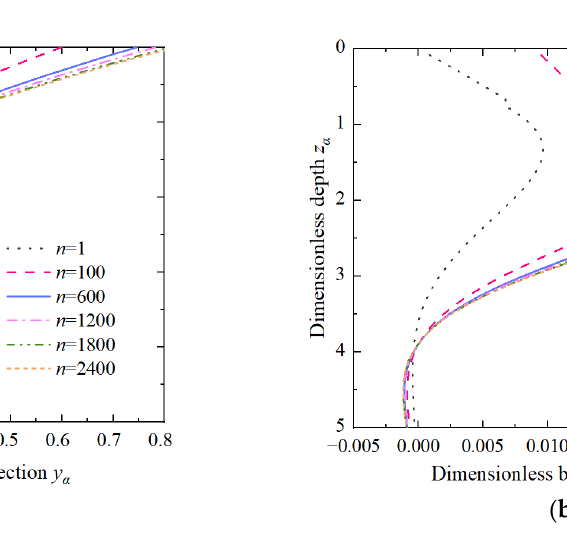
Figure 15. Predicted dimensionless pile deflection and bending moment profiles under different cycle numbers in test C2. ( a ) pile deflection profile; ( b ) bending moment profile.